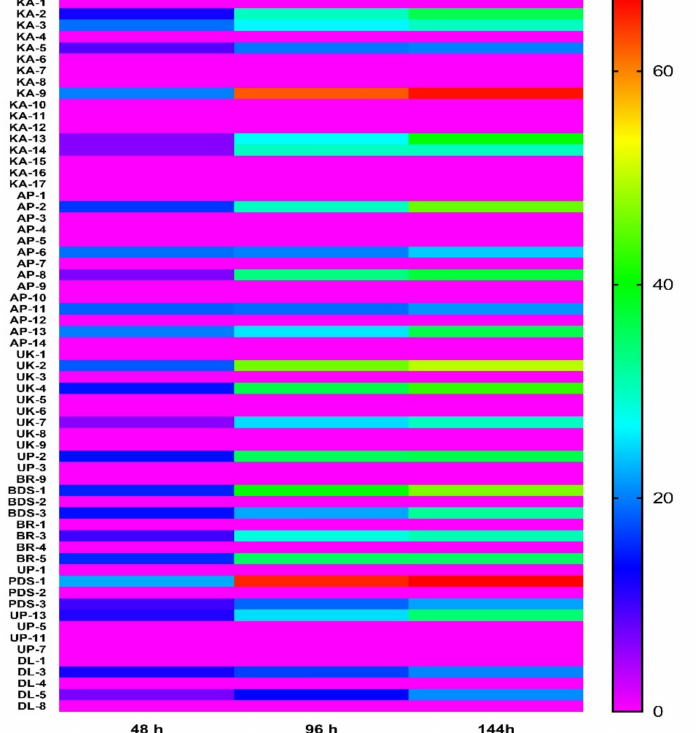
Figure 2. Biocontrol efficacy of fungal strains isolated from different regions at different time intervals (48 h, 96 h and 144 h). The results are expressed as average of three replications.